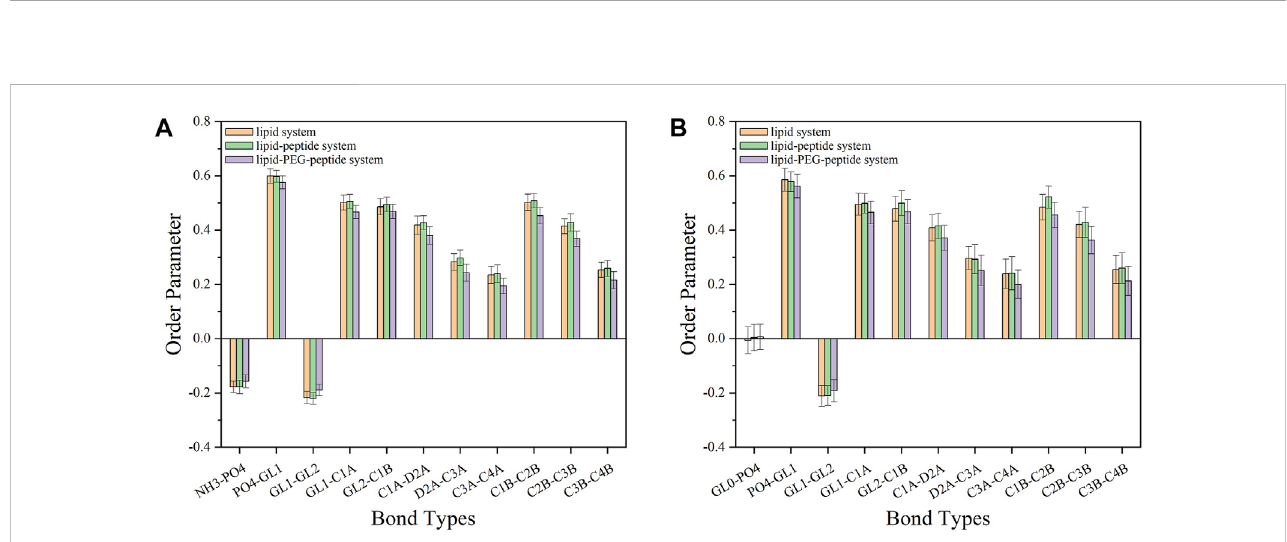
FIGURE 10 The order parameters of different bonds on POPE lipids (A) and POPG lipids (B) in lipid system, lipid-peptide system and lipid-PEG-peptide system.